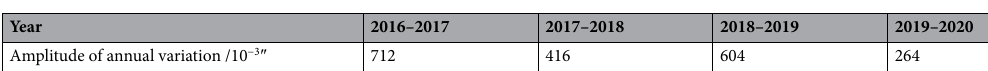
Table 2. Statistics of the annual variation of the EW component of the vertical pendulum